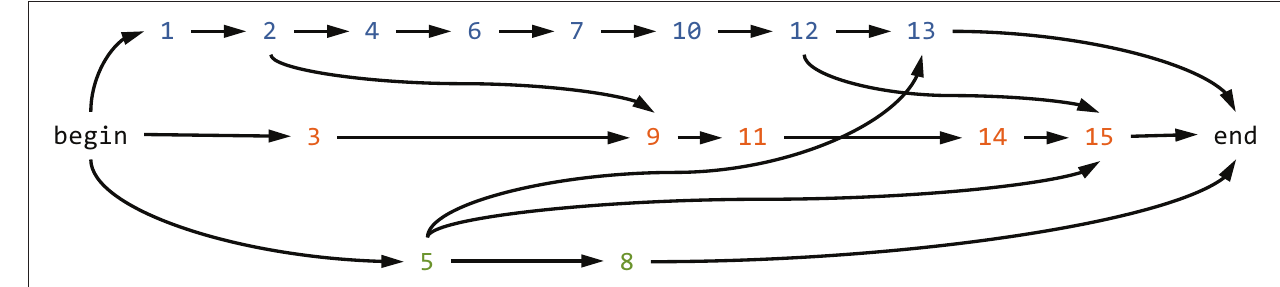
FIGURE 4 | Read graph-based global haplotype reconstruction. Shown is the read graph for the first 15 reads of the MSA shown in Figure 2 . Each read is represented by its index and colored according to its parental haplotype (A, blue, first row; B, orange, second row; and C, green, third row). Reads are